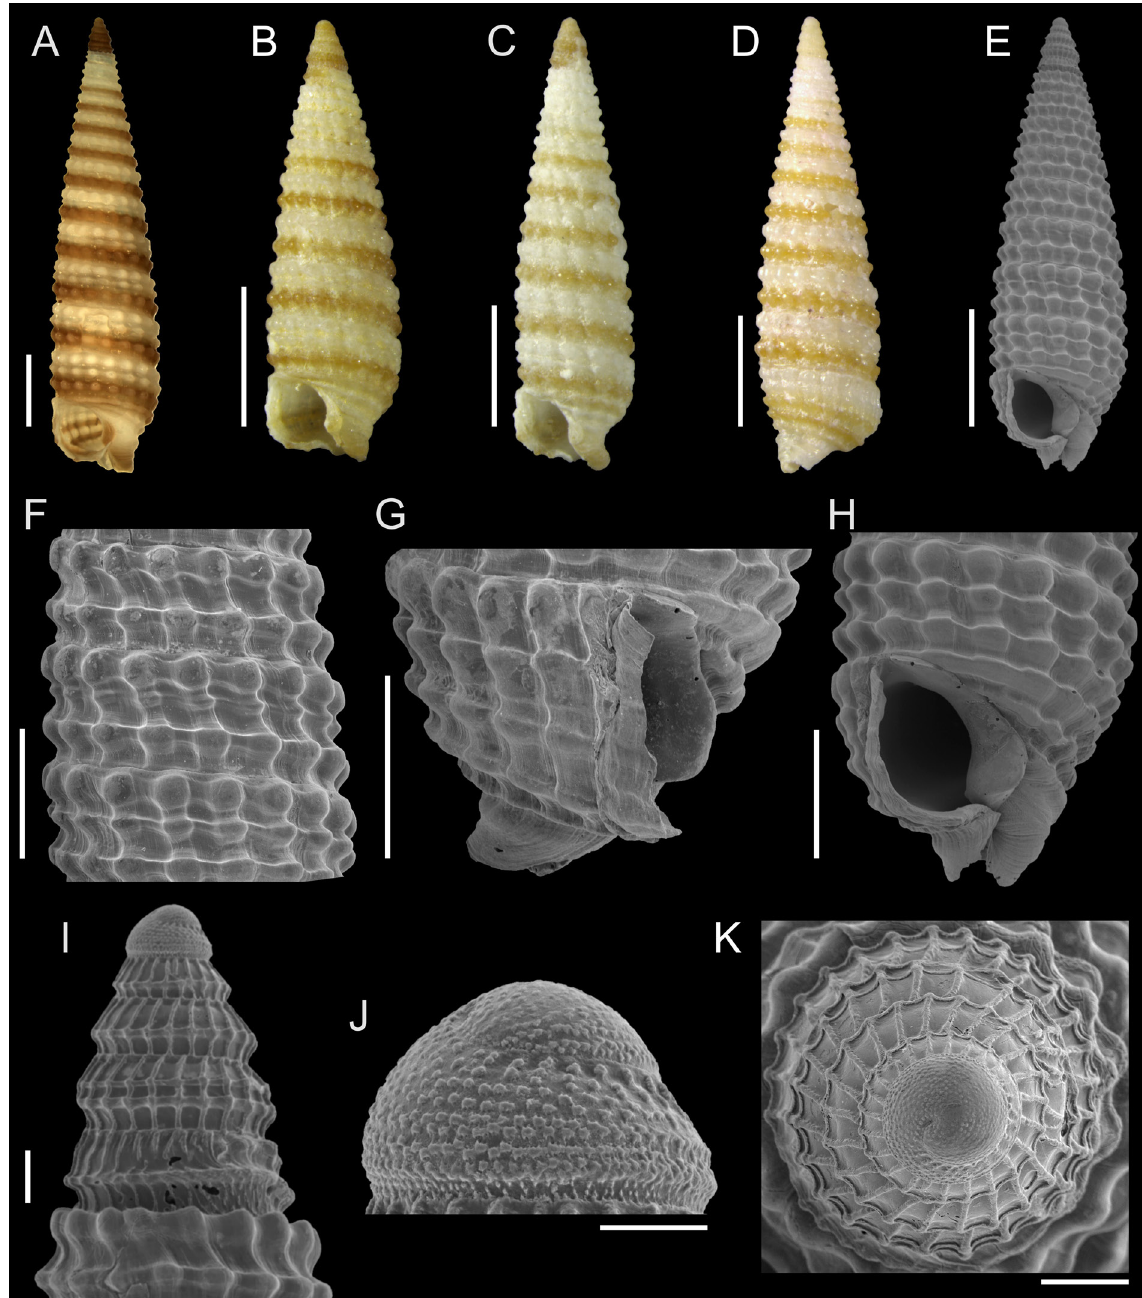
Fig. 97. Triphora elvirae De Jong & Coomans, 1988. A . MNRJ 18619*, 6.32 mm. B . MNRJ 31069*, 3.16 mm. C . MNRJ 31493*, 3.73 mm. D . MNRJ 33813*, 4.12 mm. E . MNRJ 18617*, 3.87 mm. F–G . MNRJ 18754*. H–K . Same shell as E. Scale bars: A–E = 1 mm; F–H = 500 µm; I, K = 100 µm; J = 50